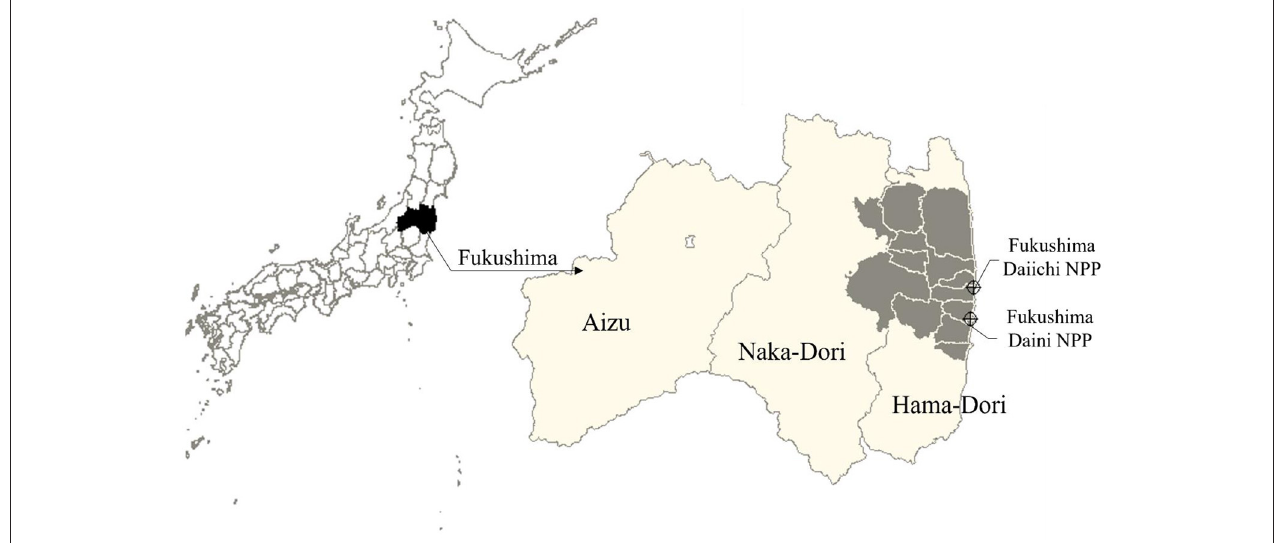
FIGURE 1 | Map of Fukushima Prefecture. These maps have the north on top. The map of left shows Japan and the map of right shows Fukushima Prefecture. In the Fukushima’s map, the gray areas are municipalities with evacuation-directed